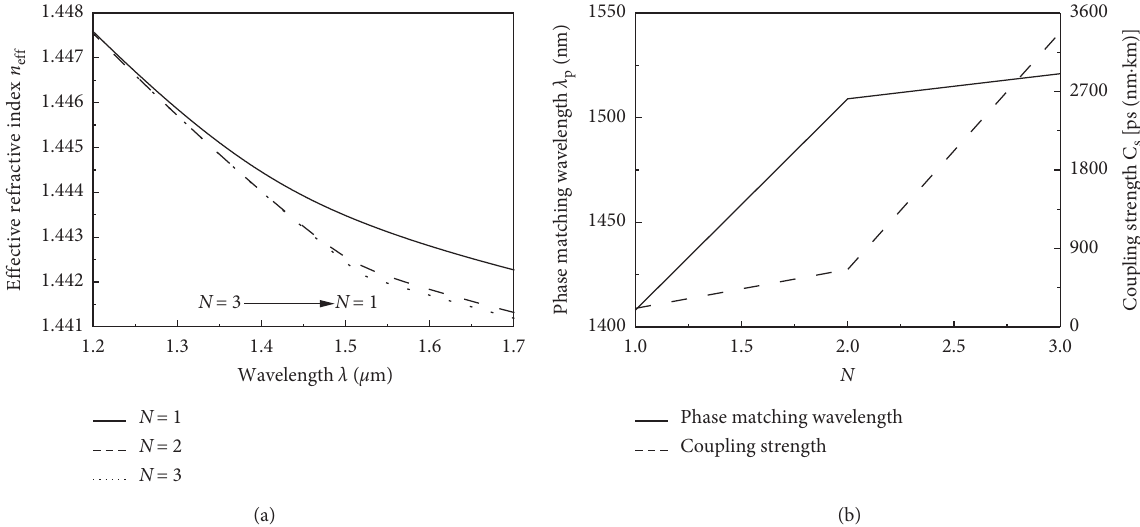
Figure 8: Variation of the effective refractive index of the fundamental supermodel with wavelength when N is changed (a) and λp and the coupling strength with N (b).